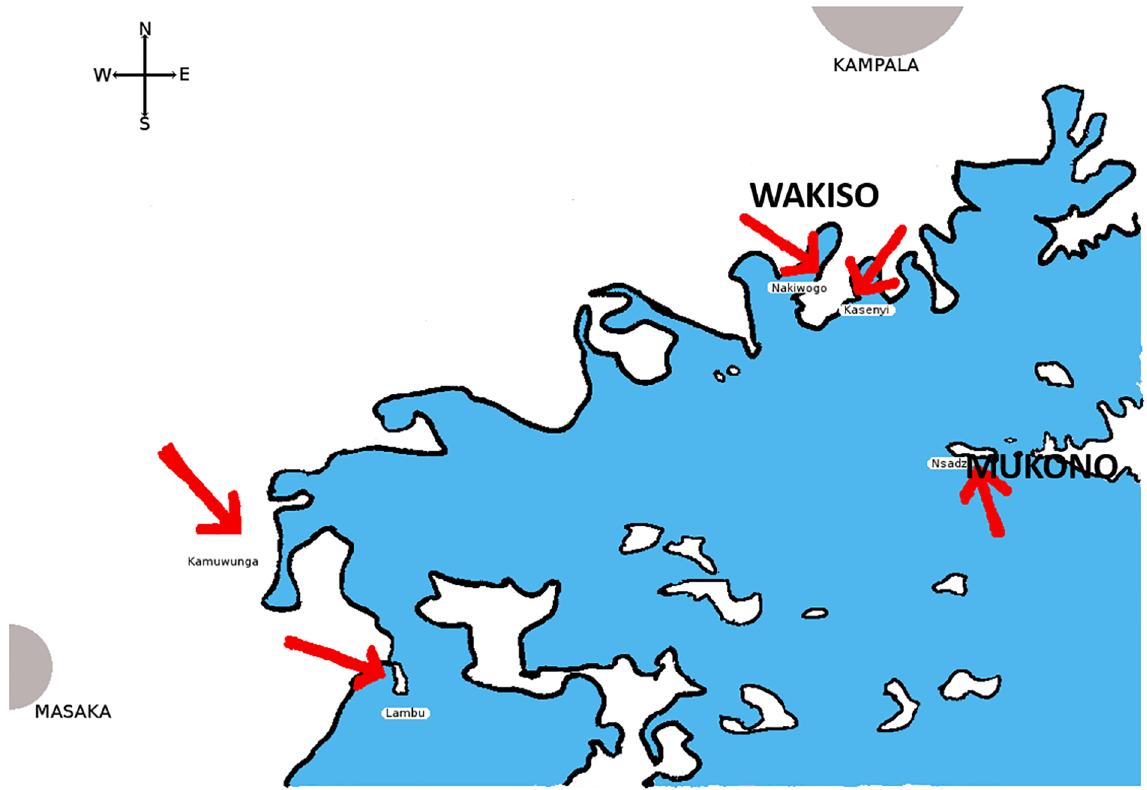
Fig 1. Study area. Lake shore districts Masaka, Mukono and Wakiso.